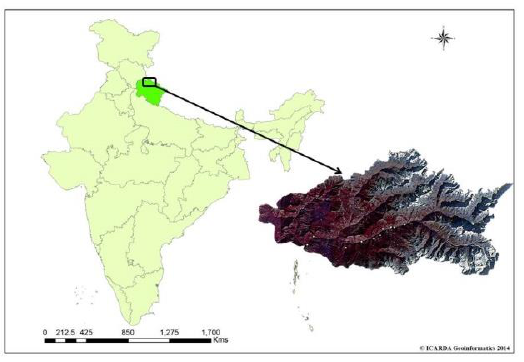
Figure 1 . Location of the study area